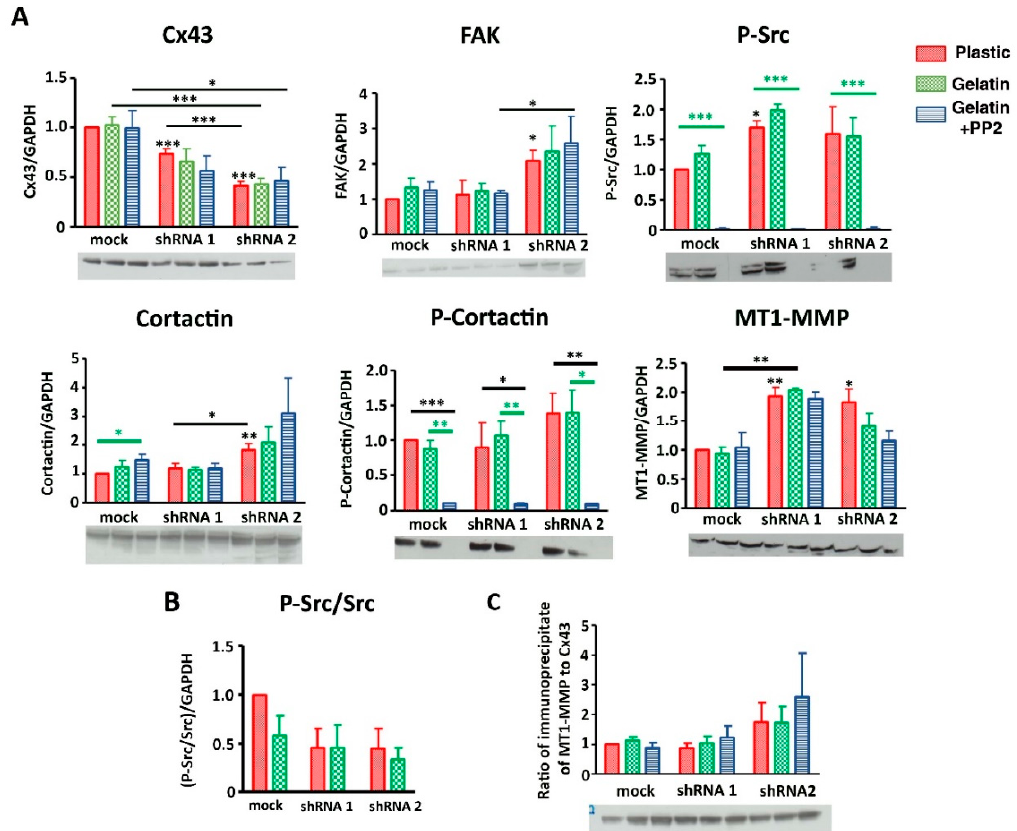
Figure 7. Protein (Cx43, FAK, P-Src, cortactin, P-cortactin, MT1-MMP) expressions and interactions in correlation with Cx43 expression. ( A ) First line: Densitometric analysis of Cx43 (left), FAK (middle) and P-Src (right) expression levels after normalization to GAPDH expression. Cx43 is significantly reduced in shRNA clones compared to mock cells cultivated on plastic (control, red), gelatin (0.2%, green) or gelatin + PP2 (5 µM, blue) conditions (N = 9). Second line: Densitometric analysis of cortactin (left), P-cortactin (middle) and MT1-MMP (right) protein expression level after normalization to GAPDH expression according to Cx43 expression level (N = 5). ( B ) Representation of Src activity by Src/P-Src ratio, (N = 5) ( C ) Ratio of immunoprecipitation of Cx43 from U251 cells and immunoblotting of MT1-MMP (N = 3). Red bar highlights differences due to gelatin culture condition and black bar highlights differences due to diminution of Cx43 expression. Representative blots are presented under all densitometric analysis. * p < 0.05; ** p < 0.01 and *** p < 0.001. Values shown as mean ± SEM (see Supplementary Table S1).